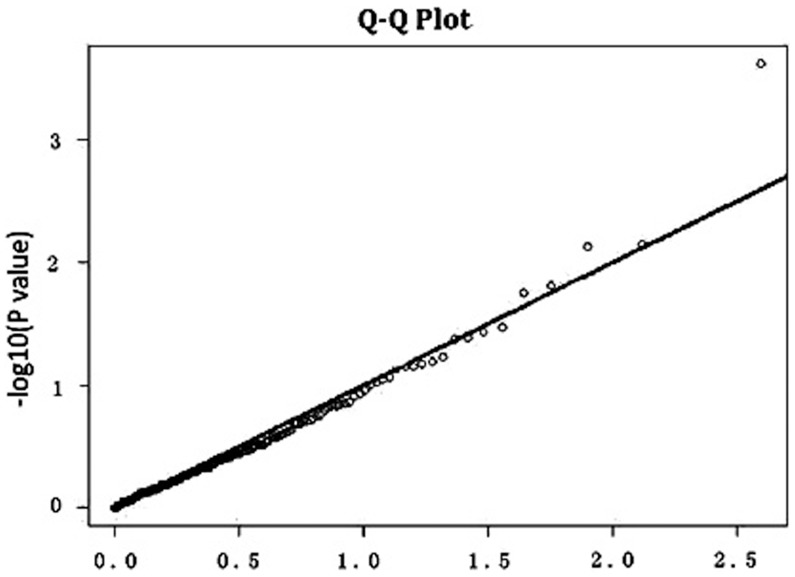
Quantile–quantile (Q–Q) plot for height.From the Q–Q plot, the observed p-values for height match the expected p -values under the null distributions over the range of (1<-log10(p)<3.0). Furthermore, an excess of low p -value is observed above 3.0 of -log10(p) for height.